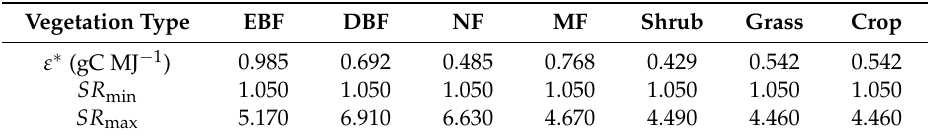
Table 1. The value of maximum light utilization efficiency ( ε ∗ ), SR min , SR max for different vegetation